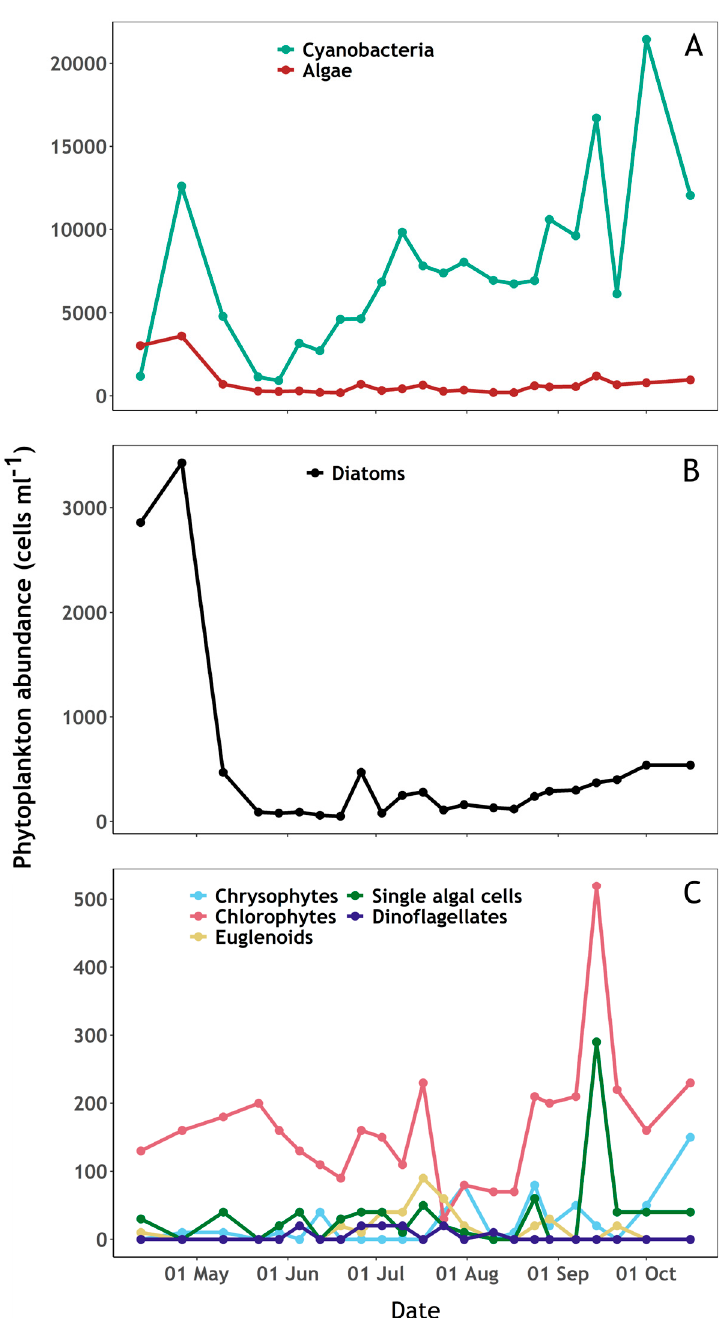
Figure 3. Phytoplankton abundance (cells mL − 1 ) during the sampling period at Roadford Lake. A: Cyanobacteria and algae. B: Diatoms. C: Chrysophytes, Chlorophytes, Euglenoids, Dinoflagellates and single algal cells.